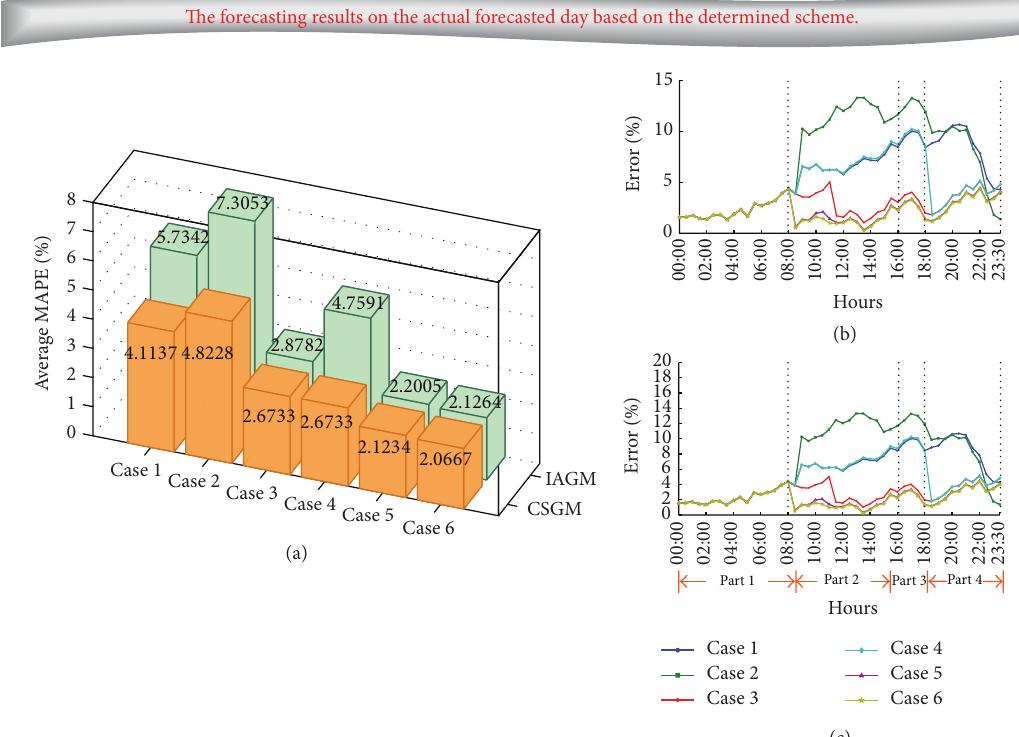
Figure4:TheforecastingresultsfortheIAGMandCSGMmodelsbasedonsixdifferentcases. (a)TheaverageerrorsofIGAMandCSGMand the error values. (b) The forecasting errors of CSGM in six cases. The black dashed lines represent fences of different part. (c) The forecasting errors of IAGM in six